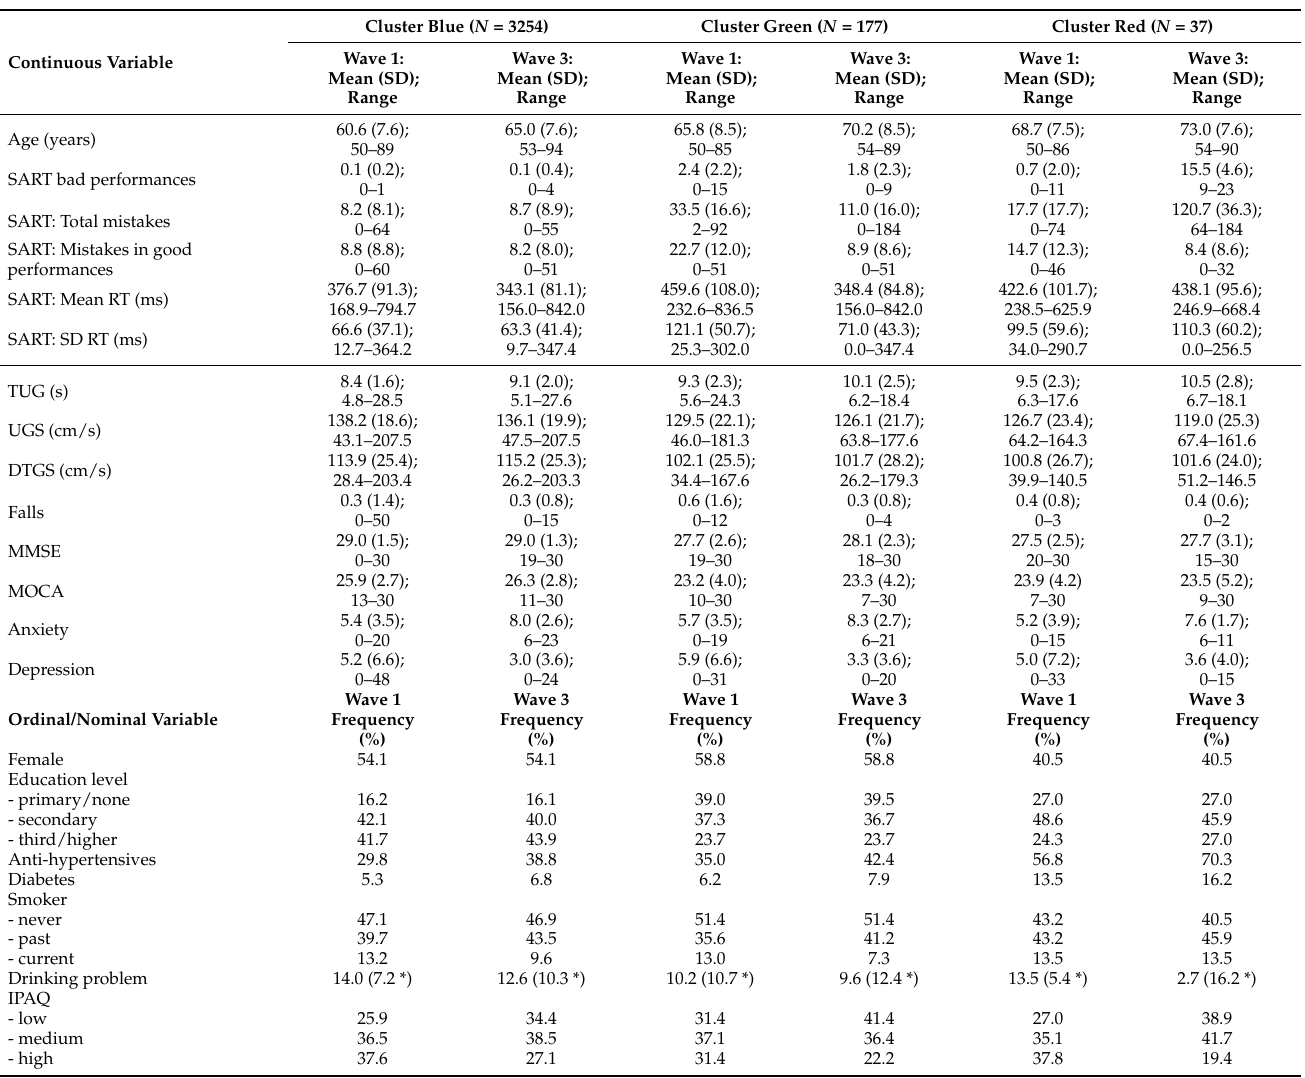
Table 5. Descriptive statistics for the whole set of variables considered in this study at wave 1 and wave 3 for each cluster. The first part of the table gives minimum, maximum values, and mean and SD for each continuous variable. The second part shows ordinal or nominal variables and their frequency in